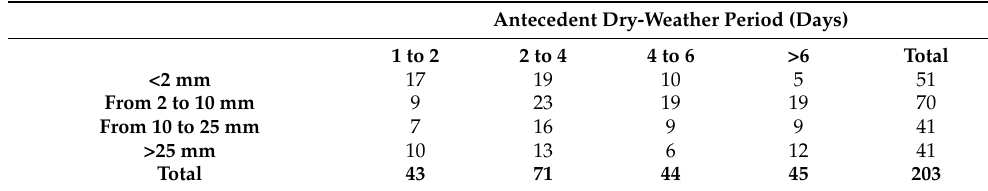
Table 1. Number of studied storm events by rainfall size grouping (rows) and antecedent dry-weather period